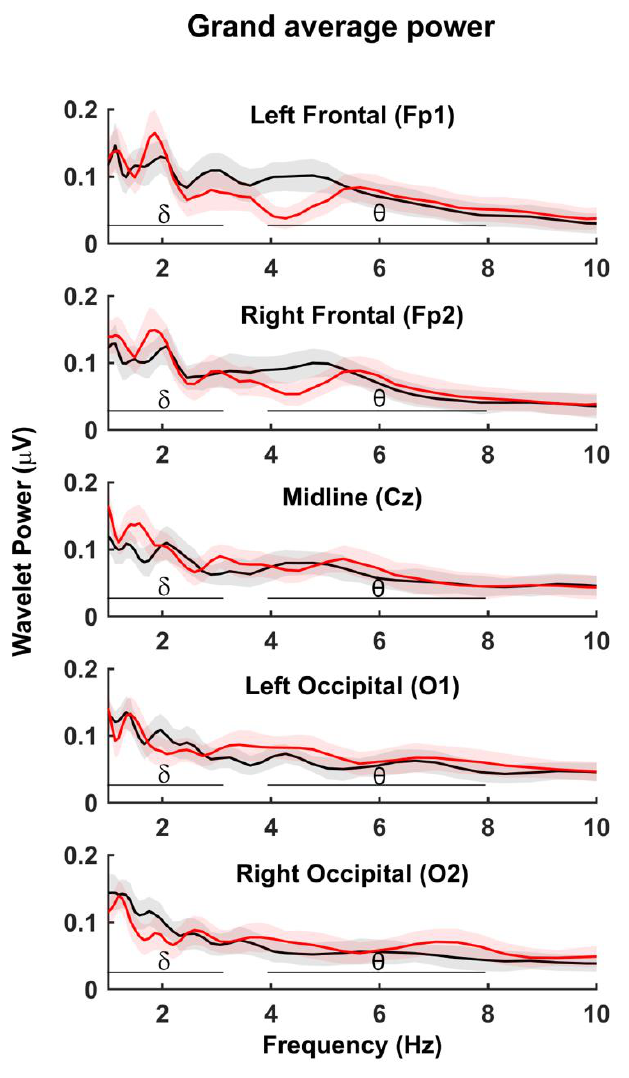
Figure 4. Grand average wavelet power at each of the 5 electrode sites. PRE (black) POST (red). Shading shows standard error and horizontal bars show delta and theta band analysis regions.